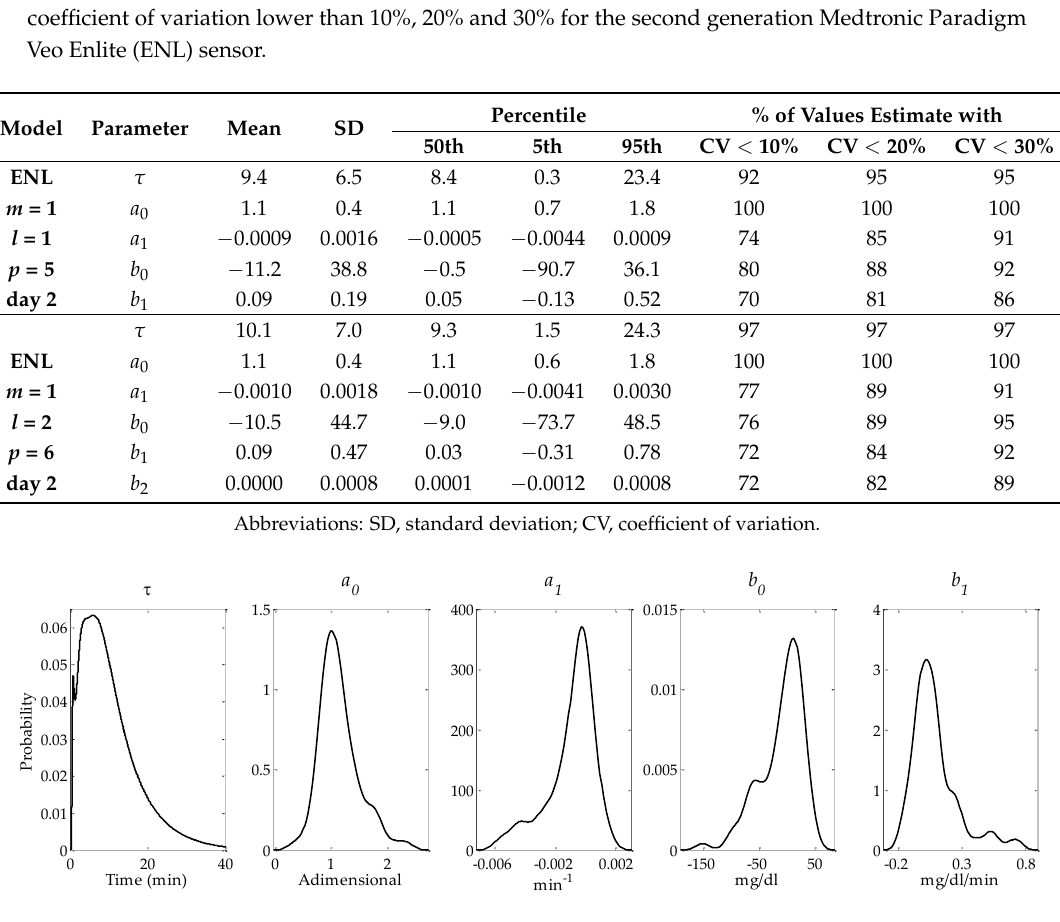
Figure 4. Probability density functions of parameters τ , a 0 , a 1 , b 0 , and b 1 obtained applying a kernel density estimation